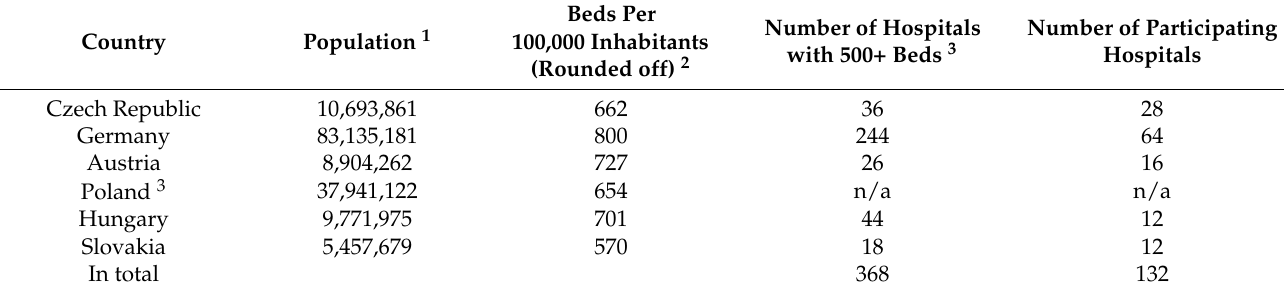
Table 3. Specification of the hospital sample